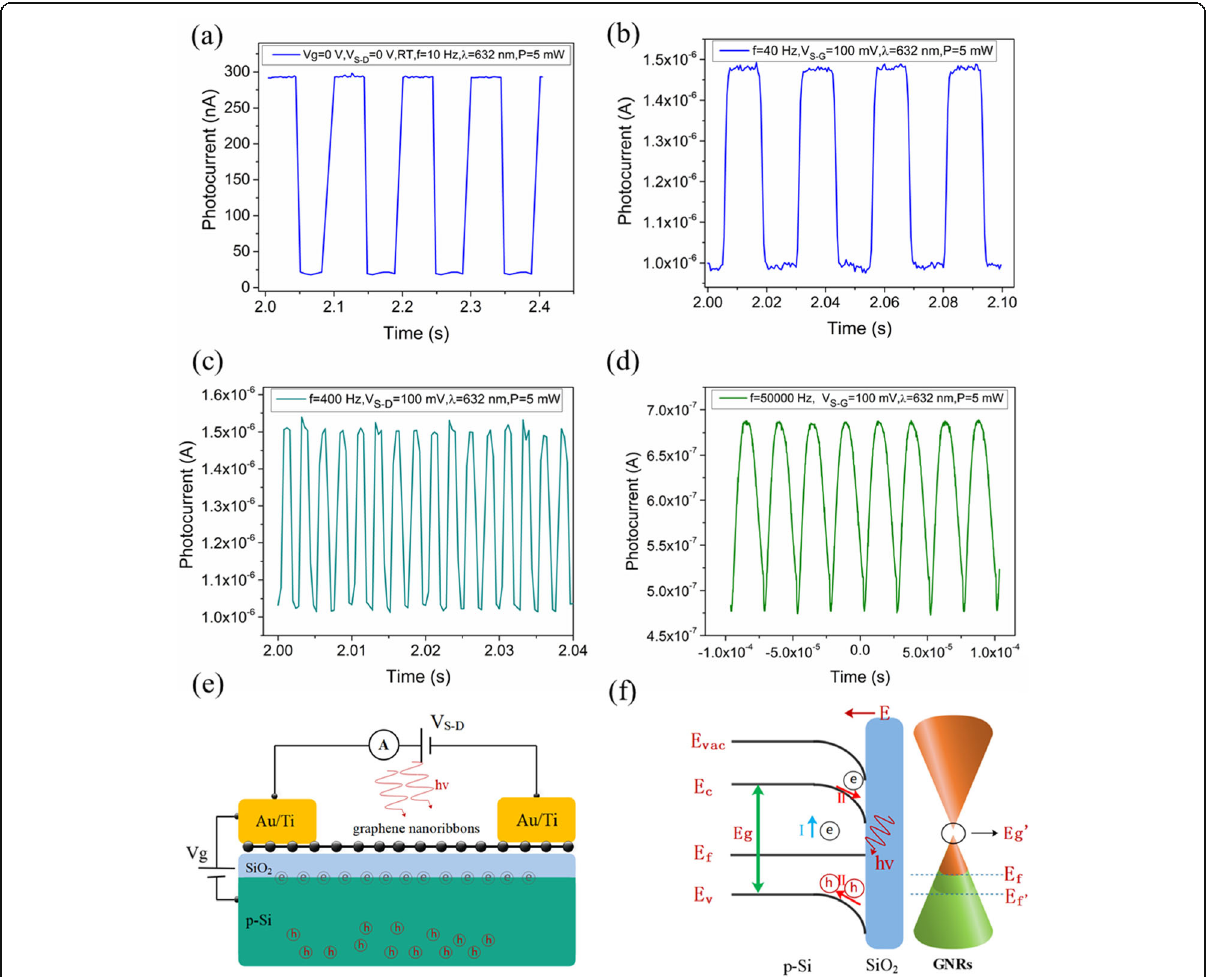
Fig. 2 a Time-dependent photocurrent measurements of the device without the biased of back-gate and source-drain voltage under on-off light (632 nm) modulation at room temperature. The time-dependence photocurrent was measured under laser illumination with a frequency of 40 Hz ( b ), 400 Hz ( c ), and 5000 Hz ( d ). e Schematic diagram of the GNR photodetector. f Energy diagram of the interface between Si and SiO 2 upon light illumination. E C , E V , E fs , and E VAC are the conduction band, valence band, Fermi level, and vacuum level, respectively. E f and E f ’ are the Fermi level before and after the injection of the electron to the GNR channel. E g ’ is the bandgap of GNRs. Two processes are illustrated: (I) electronic transition from the value band to the conduction band under illumination in Si and SiO 2 ; (II) hole transfer from SiO 2 to Si and photon excited carriers drifted through the built-in